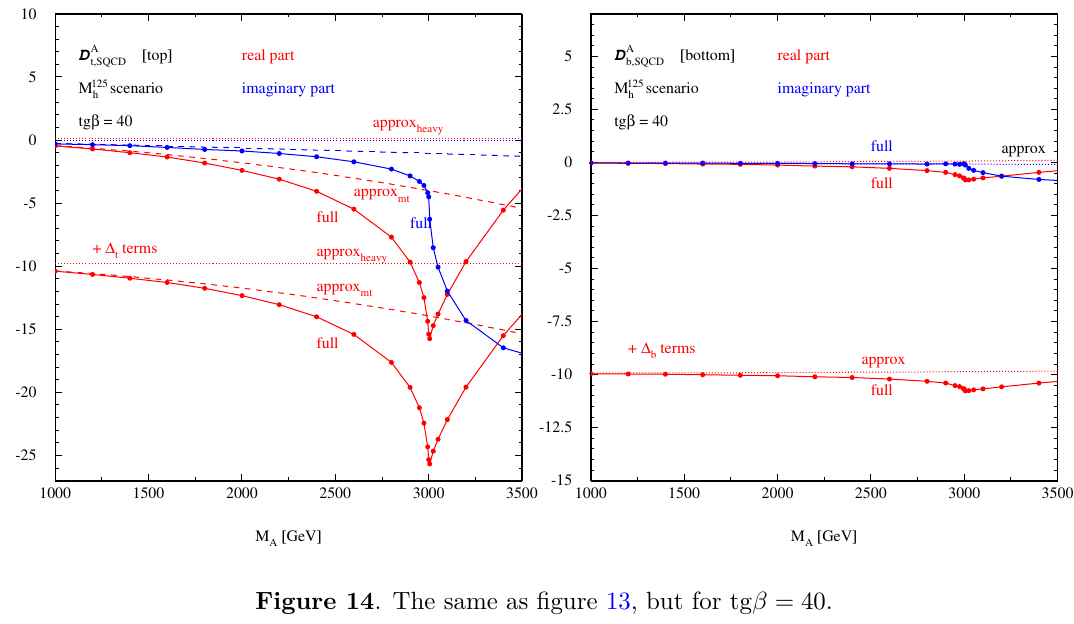
Figure 14 . The same as figure 13, but for tg β = 40 .